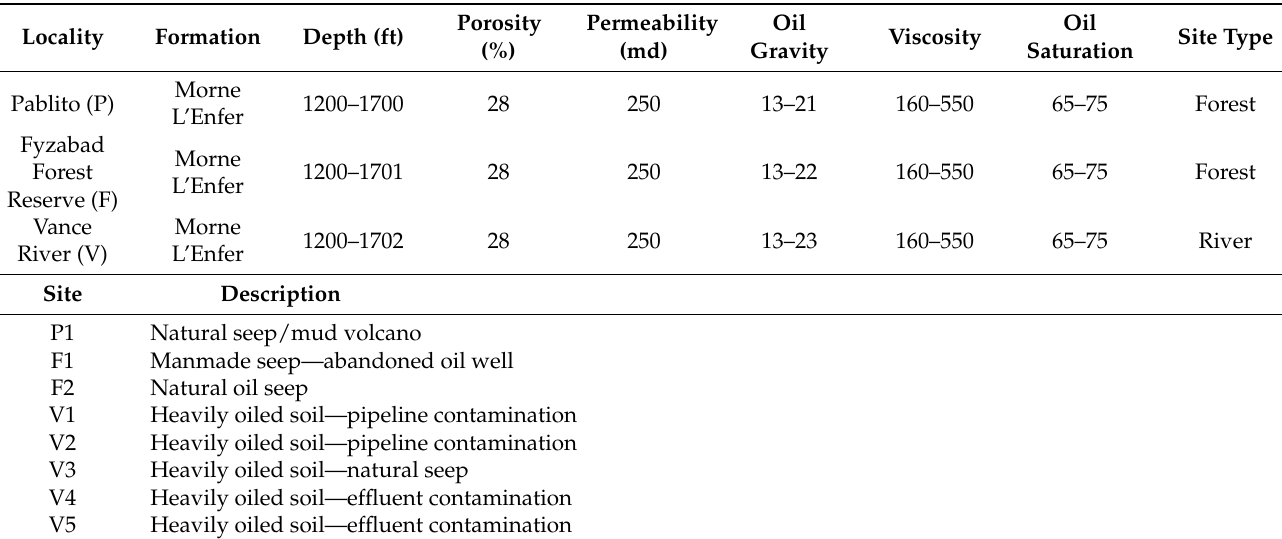
Table 1. Sampling data of the 8 geographically separated sites and the physical properties [58] of the 3 geographically separated localities in southwestern